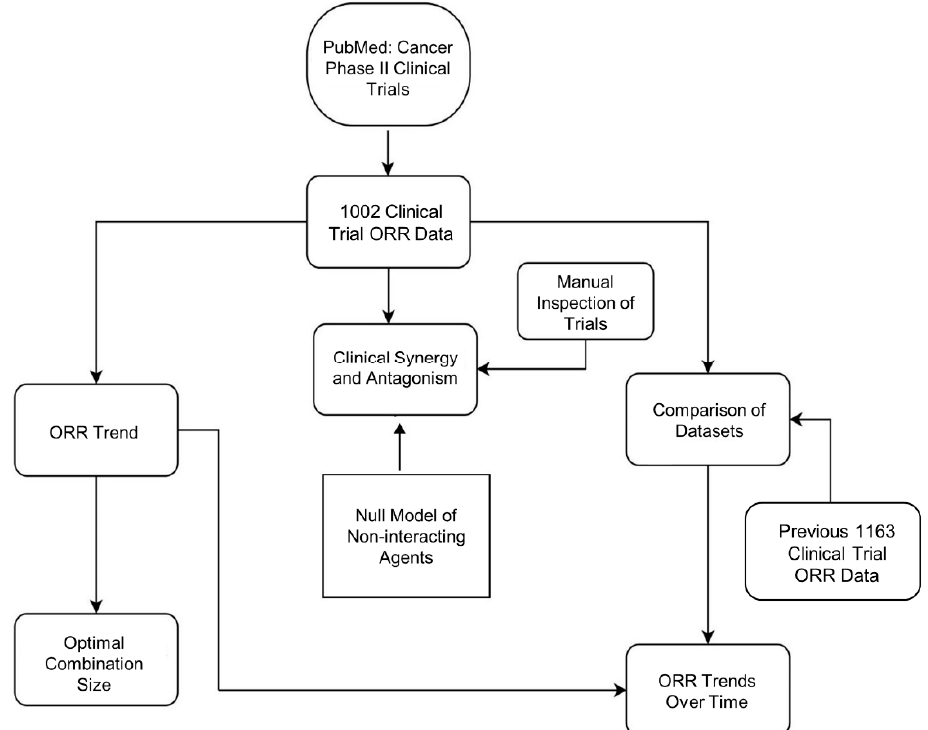
Figure 1. Study design and workflow. Previous 1163 ORR and null model from Kang et al. [38].